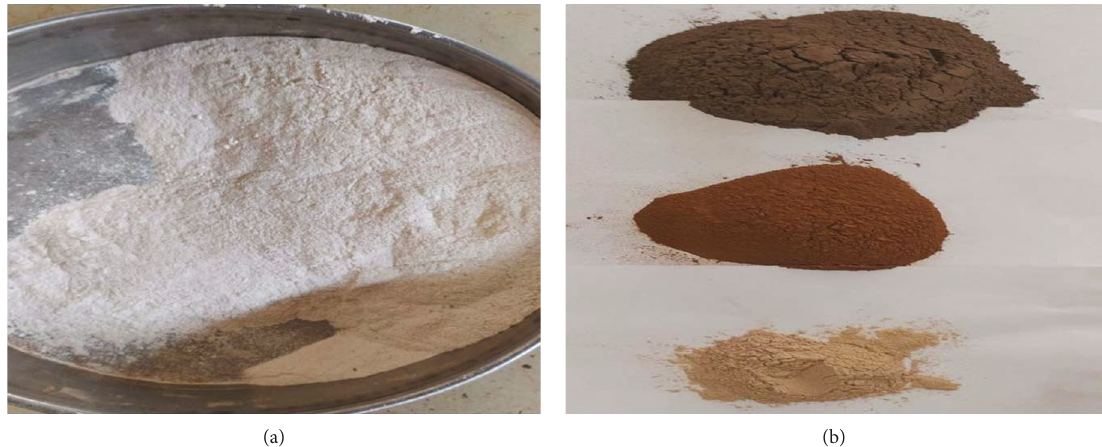
Figure 2: Prepared sample: (a) powdered glass and (b) soil and stabilizers.